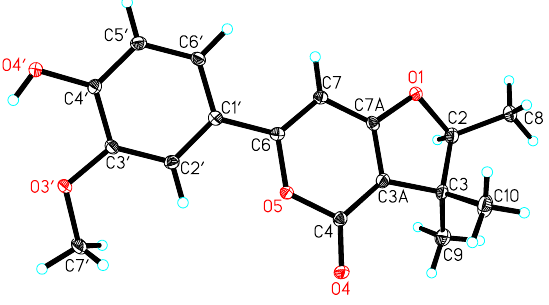
Figure 3. X- ray structure of 1 .